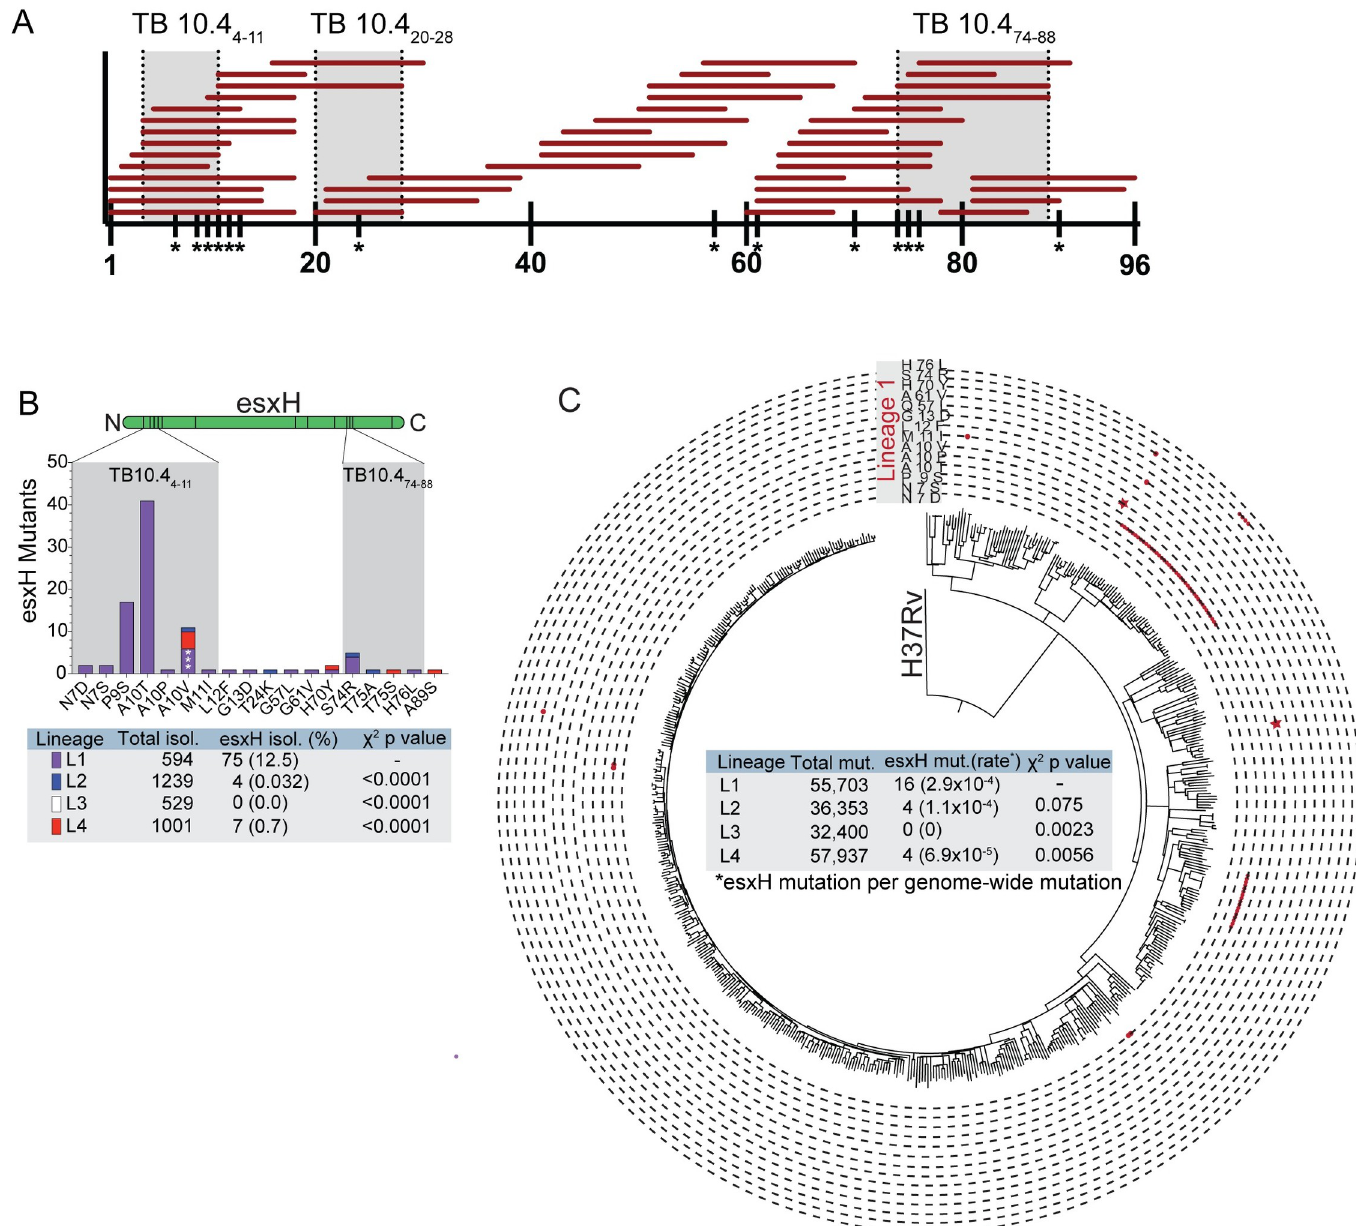
Fig 1. The esxH gene is highly polymorphic among clinical Mtb isolates. (A) Reported TB10.4 epitopes recognized by human T cells from the IEDB database (www. iedb.org). Y axis represents the length of the 96 amino-acid TB10.4 protein. Each horizontal red bar spans an individual reported epitope. Grey shaded areas represent mouse TB10.4-specific T cell epitopes: H2-K b -restricted TB10.4 4 − 11 , H2-K d -restricted TB10.4 20 − 28 , and I-A d -restricted TB10.4 74 − 88 . (B) The locations of EsxH polymorphisms are represented along the linear sequence of the protein (green), with the number of isolates containing each polymorphism based on the whole genome sequences from Holt et al and Walker et al [25, 26]. Regions of the protein with a high frequency of polymorphisms are shaded grey. The bar color corresponds to the different Mtb lineages: lineage 1 (L1), purple; L2, blue; L3, white; and, L4, red. The table shows the total numbers of polymorphisms in each lineage, and the χ 2 and p values compared to L1. (C) Whole-genome SNP-based phylogenies represent the polymorphisms across all clinical isolates within lineage 1. Each circumference line signifies a distinct polymorphism indicated in the grey box labeled “Lineage 1.” Each red dot cluster represents each time the indicated polymorphism evolved independently. Red stars designate the A10V polymorphism which evolve separately three times. The table shows the acquisition rate of esxH variations based on the identification of genome- wide SNP events within each phylogeny and the number of events which were within esxH.